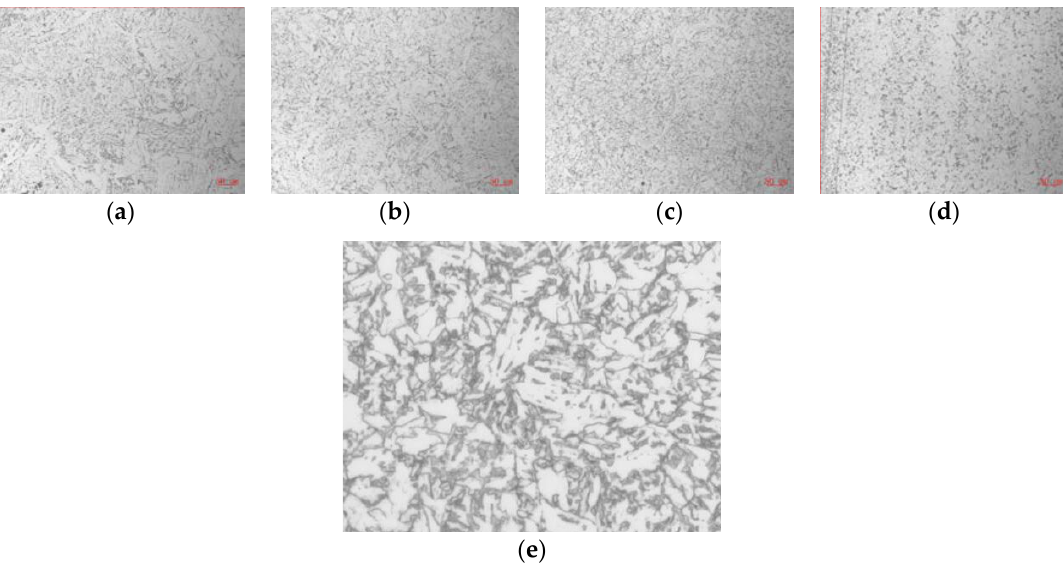
Figure 8. Metallographic structure of HAZ for 40 mm thickness: ( a ), the metallographic structure of welding fusion zone; ( b , c ), the metallographic structure of welding heat affected zone; ( d ), the metallographic structure of the steel plate; ( e ), the higher magnification image of partial area of Figure 8b.